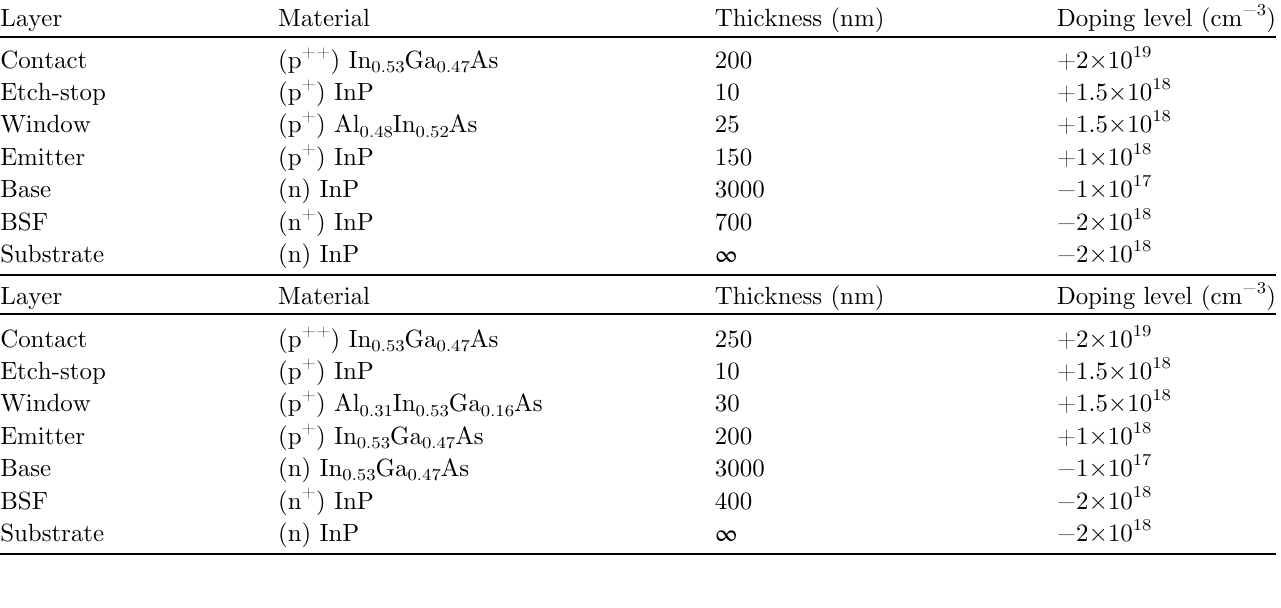
Table 1. Structure of the p + n single junction InP top cell (up) and InGaAs bottom cell